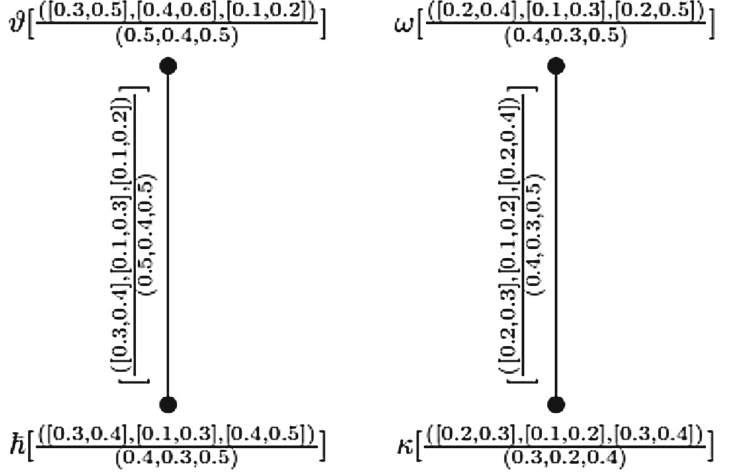
Figure 3: 3pc graphs G